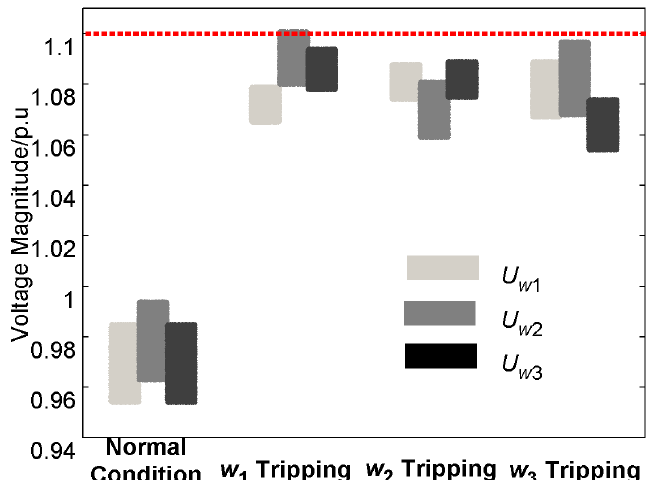
Figure 10. Voltage magnitude before/after